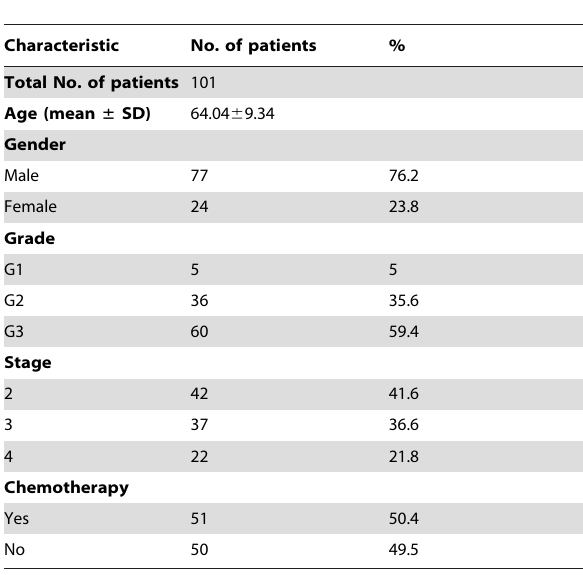
Table 1. Patient characteristics at study entry.